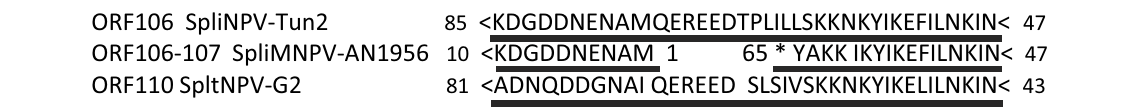
Fig. 5 Alignment of the translated ORF 106 in SpliNPV-Tun2 to the homologous ORF 106–107 of SpliMNPV-AN1956 and ORF 110 in SpltNPV-G2. Numbers and arrows on both sides of the lines indicate the amino acid position and ORF orientation in the corresponding translated gene. *indicates the stop codon of ORF 107 of